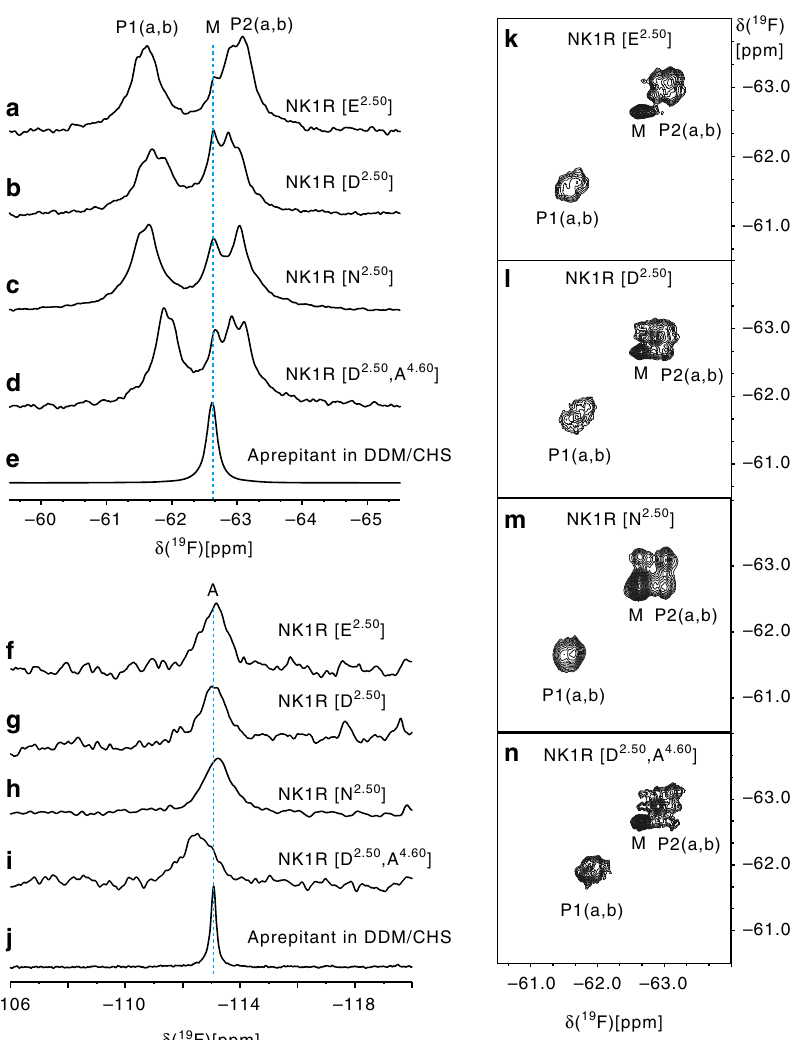
Fig. 4 19 F NMR studies of aprepitant bound to NK1R in solution. a – j 1D 19 F-NMR spectra of aprepitant in complex with different NK1R mutants and aprepitant in the DDM/CHS detergent buffer. a – e Spectral region showing the resonances of the tri fl uoromethyl groups of the bis-tri fl uoromethyl- phenylethoxy moiety; f – j Spectral region of the 4- fl uorophenyl moiety. k – n , 2D [ 19 F, 19 F]-EXSY spectra recorded with a mixing time of 150 ms covering the same spectral region as panels a –